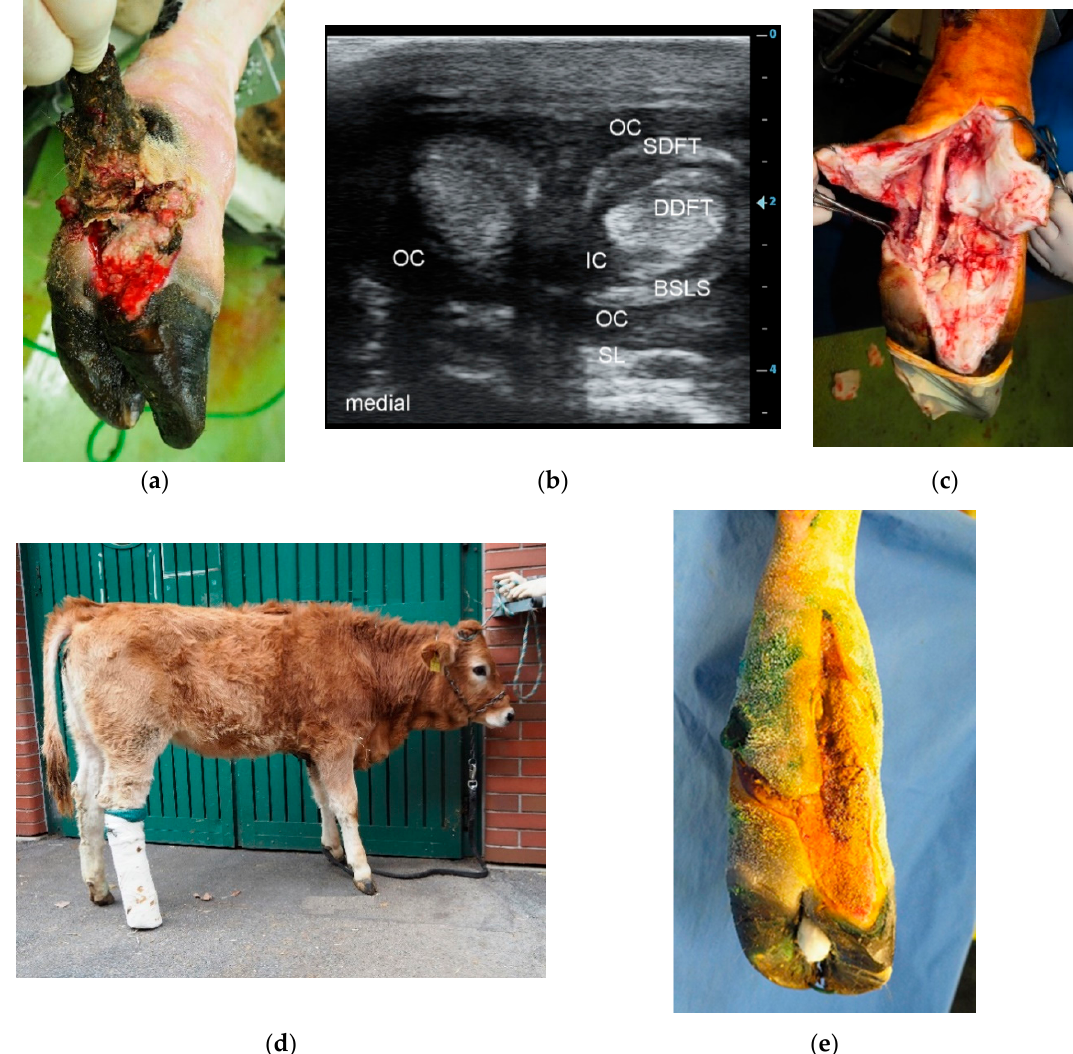
Figure 2. ( a ): Right hind limb of a seven-month-old Murbodner Blondvieh cross heifer with an eight-day old contused laceration across both DFTS with marked hypergranulation; ( b ) Transversal sonogram (7.5 MHz linear probe) of both DFTS approximately 1 cm proximal to the dewclaws showing marked distension, heterogeneous hypoechoic effusion with flow phenomena in the lateral DFTS indicating a purulent effusion and a mainly anechoic effusion with flow phenomena in medial DFTS indicating a serofibrinous effusion. SDFT: superficial digital flexor tendon, DDFT: deep digital flexor tendon, BSLS: branch of the suspensory ligament to the SDFT, SL: one of the suspensory ligament branches, OC: outer proximal compartment, IC: inner proximal compartment; ( c ) Intraoperative situation after opening of the lateral and medial DFTS, resection of both DFT of the lateral digit. The DDFT of the medial digit is visible where partial resection of tendon tissue was necessary. The entire medial DFTS was curetted and irrigated thoroughly; ( d ) The heifer eight days after surgery with a supportive bandage made of two PVC pipes; ( e ) Status at 14 days postsurgery with the wound almost entirely filled with healthy granulation tissue.